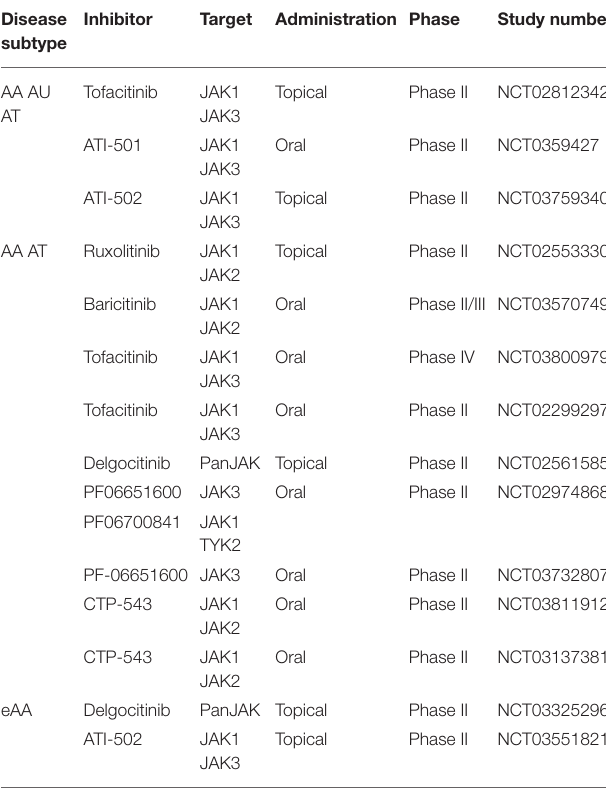
TABLE 3 | JAKi tested for atopic dermatitis. Disease subtype